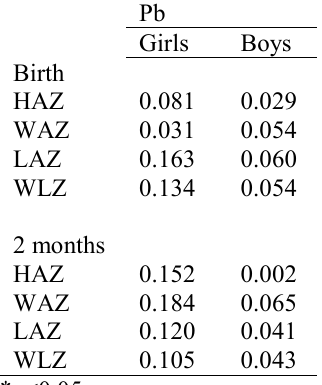
Table 5. Correlation between breast milk Pb level and z scores of anthropometric measurements at birth and 2 months